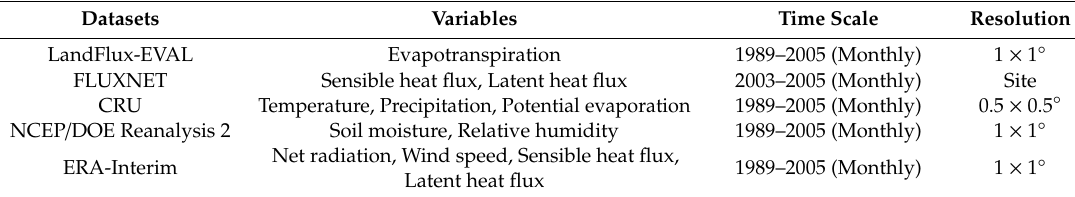
Table 1. Reanalysis datasets and variables